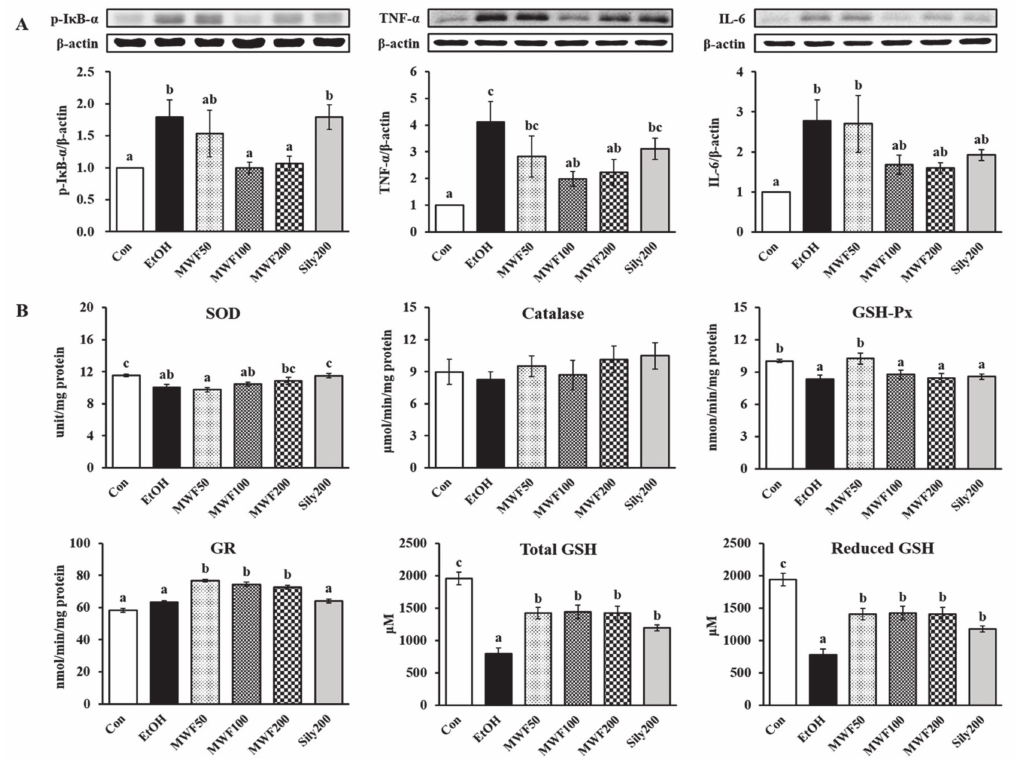
Figure 3. E ff ects of MWF on hepatic inflammatory protein expression ( A ), antioxidant enzymes activities ( B ), and glutathione concentrations ( B ) in chronic alcohol-fed rats. Mean ± SE. Statistical significance was determined by one-way ANOVA, followed by Duncan’s multiple range test. Values not sharing a common letter (a, b, c) above the bars are significantly di ff erent among the groups at p <